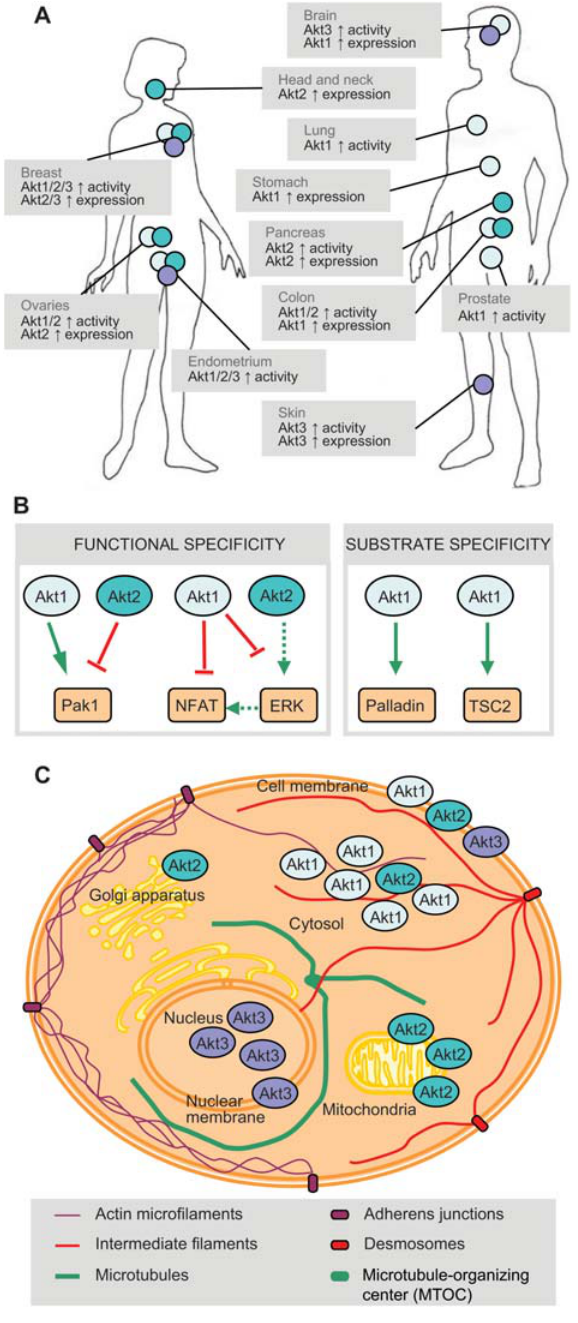
Figure 2 Mechanisms involved in the functional specificity of Akt isoforms during carcinoma progression. (A) Tissue-specific alterations of Akt isoform expression and